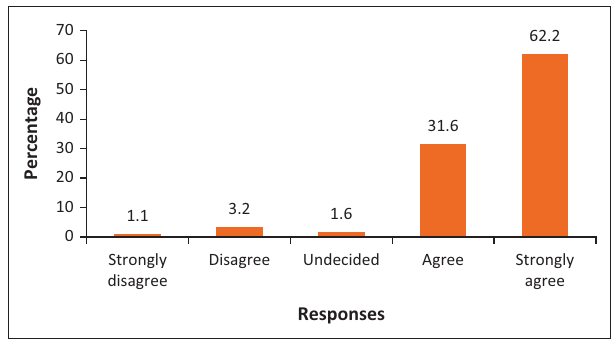
FIGURE 5: The municipality collects refuse